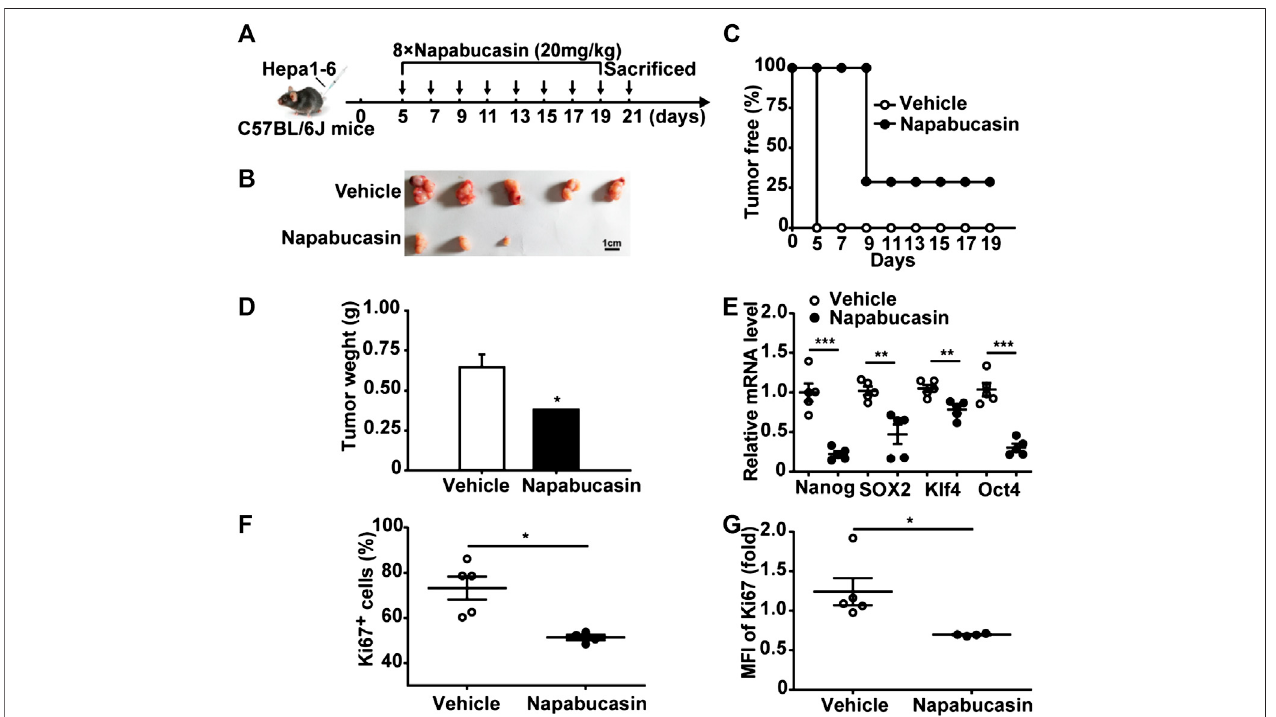
FIGURE 6 | Napabucasin inhibits HCC homograft growth in vivo . (A) C57BL/6J mice were inoculated with 5 × 10 6 Hepa1-6 cells in the left axilla, and intraperitoneally injected with napabucasin (20 mg/kg) or vehicle 5 days post-inoculation every 2 days for a total of eight injections. (B) Representative images of tumor tissues. (C) The percentage of tumor freemice. (D) Tumorweight of thesuitably treated mice. (E) Stemness marker expression in the tumor cells. Datawerenormalized to β -actin. (F) Frequency of Ki67 + cells in the tumors. (G) Ki67 levels in tumor cells from mice treated as above. MFI, mean fl uorescence index. Data represents the mean ± SD of n (cid:2) 5 and were analyzed with one-way ANOVA (* P < 0.05, ** P < 0.01 and *** P <